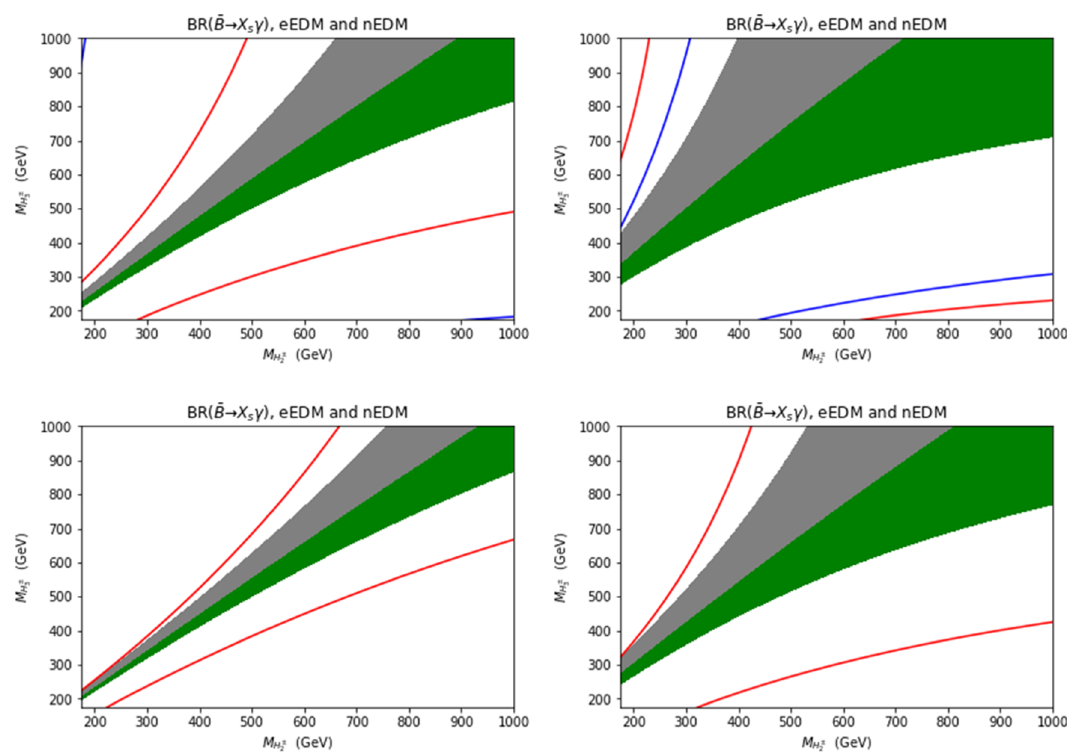
Figure 18 . Same as figure 17 but with δ = 0 . 85 π